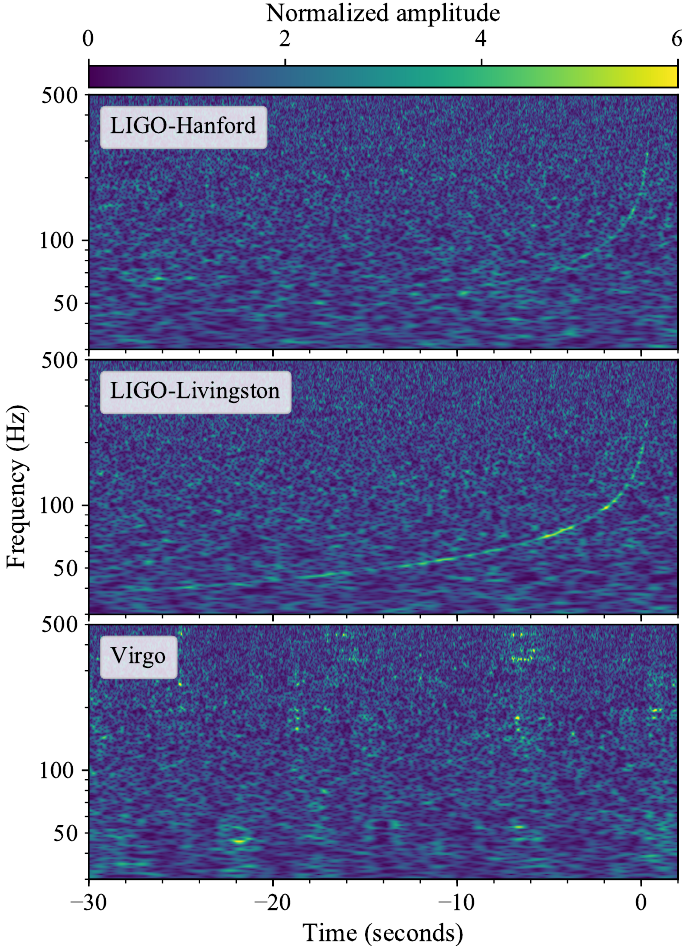
Figure 2. Time-frequency maps of the LIGO and Virgo detector outputs during the gravitational-wave event GW170817, created by the collision of two neutron stars. The signal stayed in the detector bandwidth for several tens of seconds, increasing in frequency following a characteristic chirp-like pattern. Graphics reproduced from [6] under Creative Commons